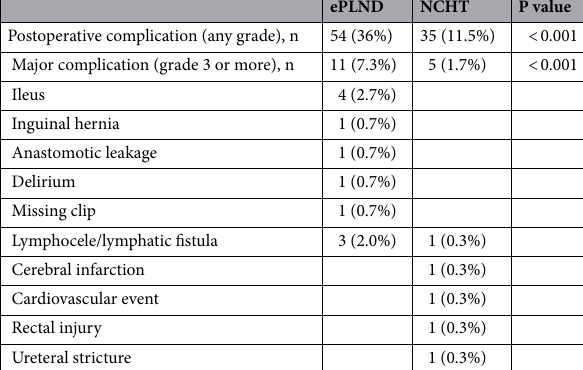
Table 2. Summary of postoperative